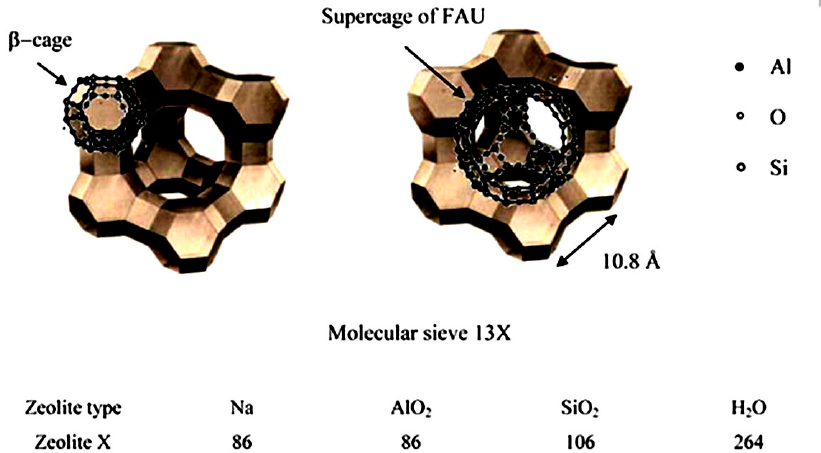
Figure 14. Structure of molecular sieve 13X. Reproduced with permission from [105]. Copyright Wiley, 2017.